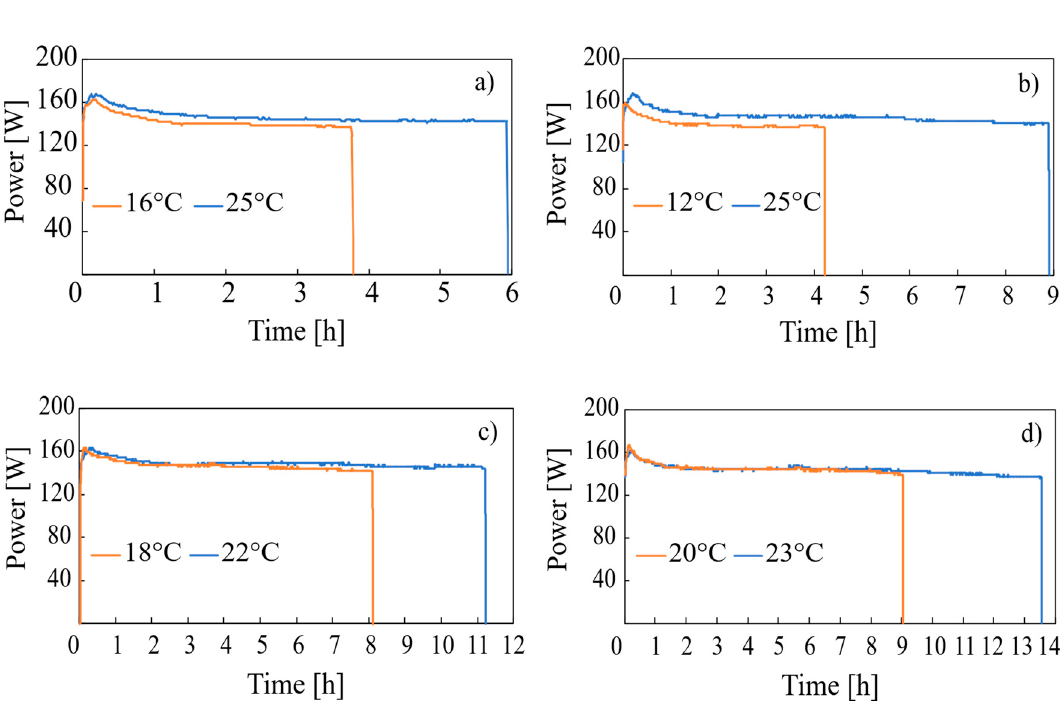
Figure 11. Consumed power in the start of the compressor for different thermal loads: ( a ) 13 kg; ( b ) 20 kg; ( c ) 23 kg; ( d ) 30 kg.